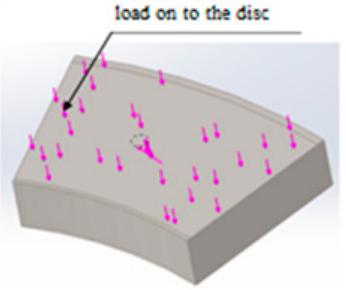
Figure 21. Acting load on the mirror surface of the disc.